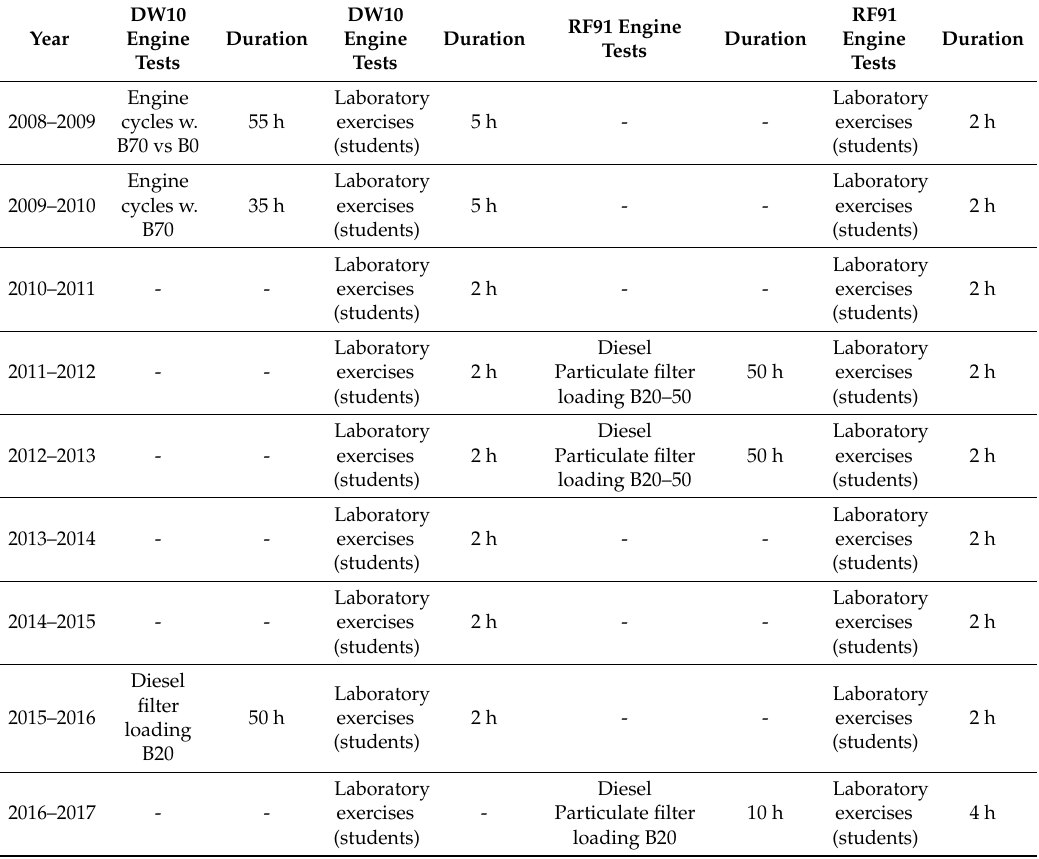
Table 7. Use of the two engines in tests and experiments in the period